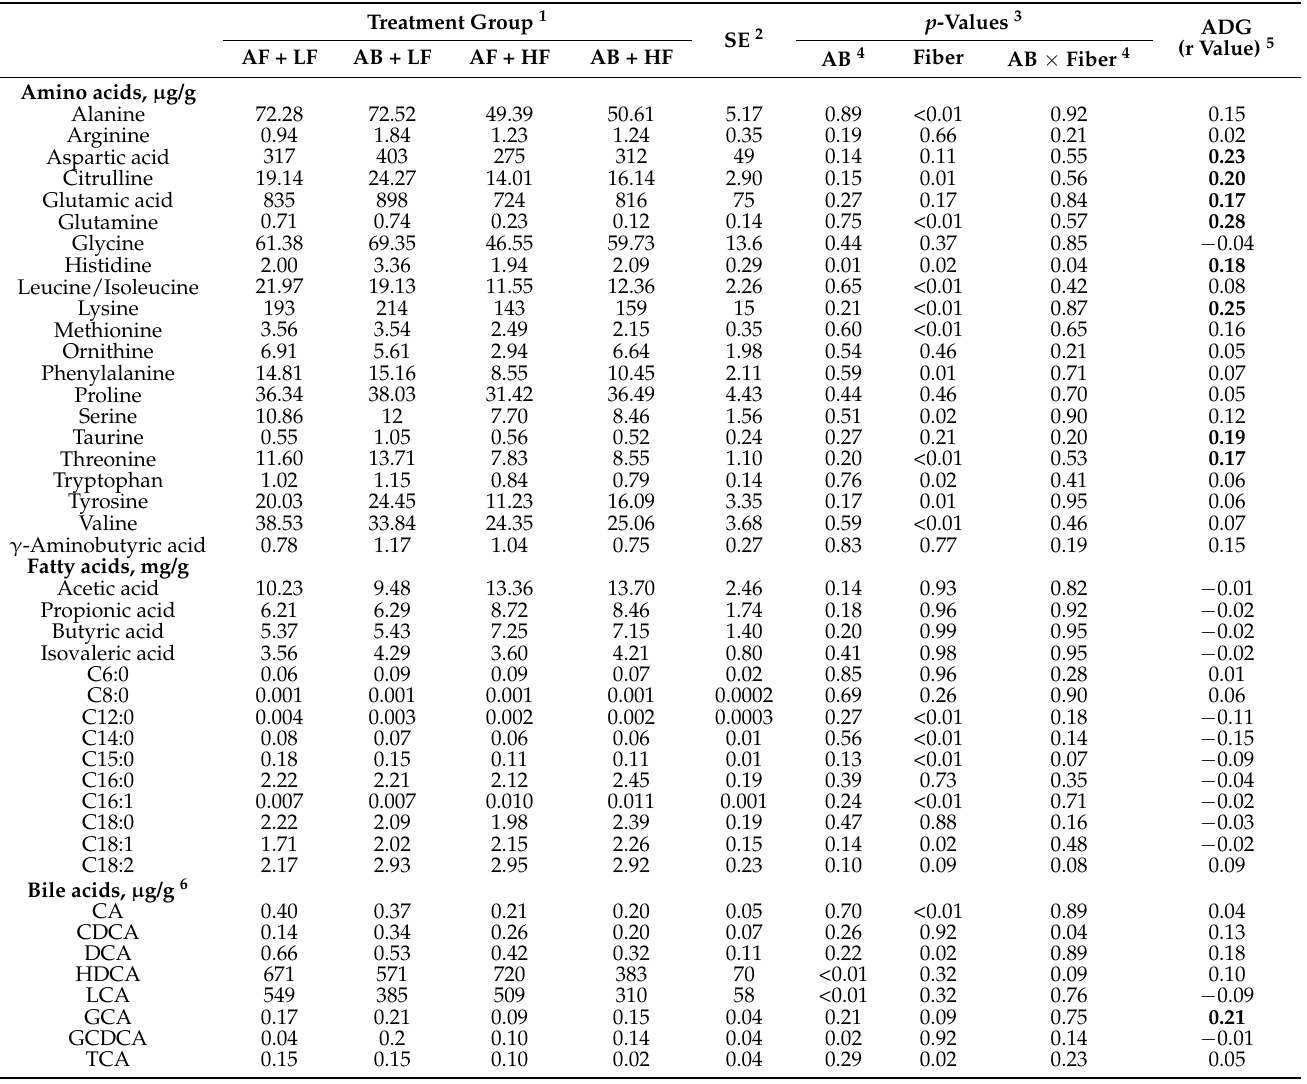
Table 2. Concentrations of free amino, free fatty, and bile acids in